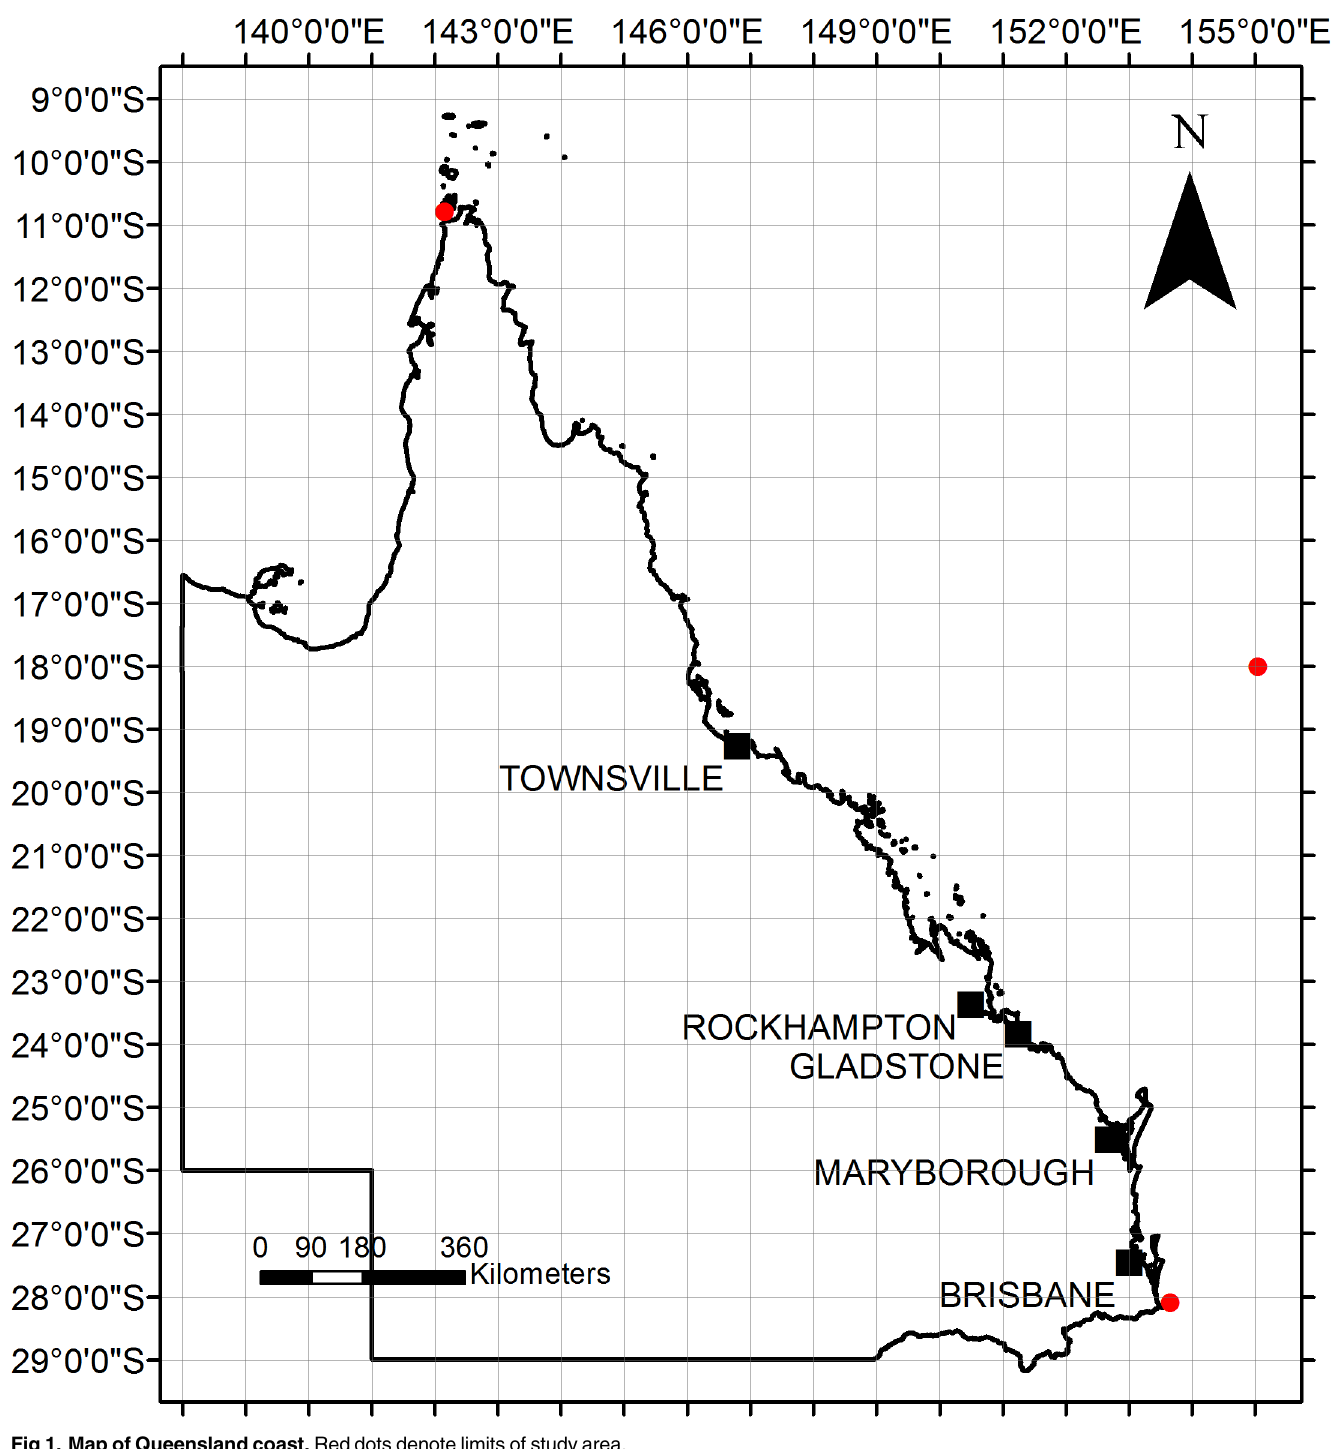
Fig 1. Map of Queensland coast. Red dots denote limits of study